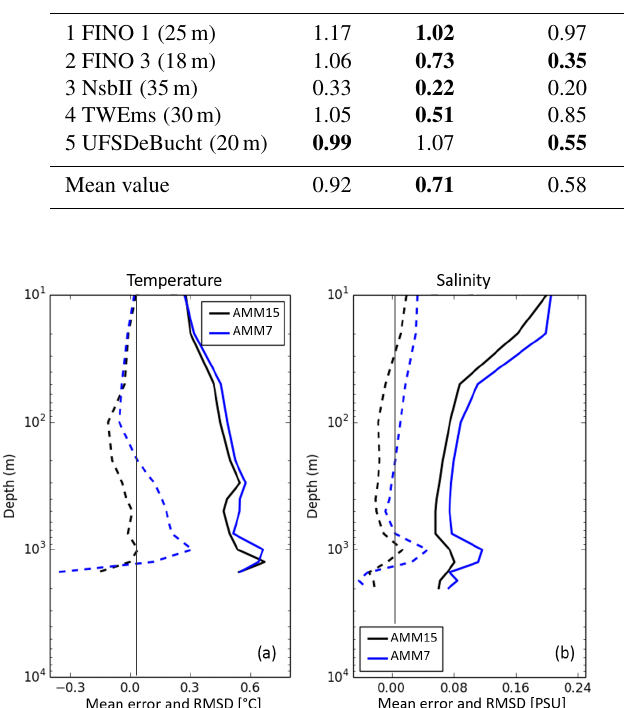
Table 10. Yearly mean (2017) RMSD and bias statistics at the five moorings in the German Bight (observation–model). Surface and bottom salinity are for AMM7 and AMM15. The values in bold indicate an improvement. Buoy ( bottom depth ) Salinity (psu) Surface Bottom RMSD Mean error